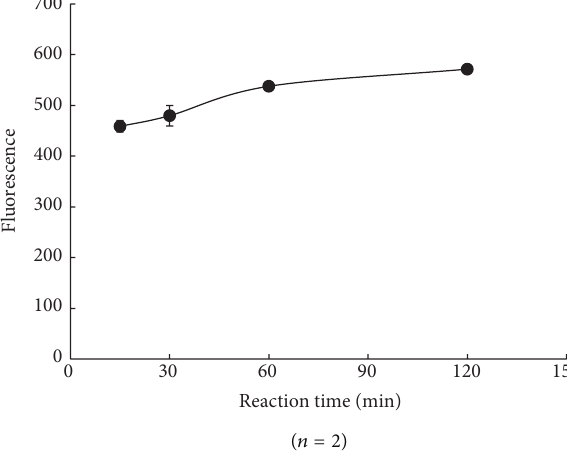
Figure 3: Effect of concentration of phosphate buffer on fluores- cence intensity.